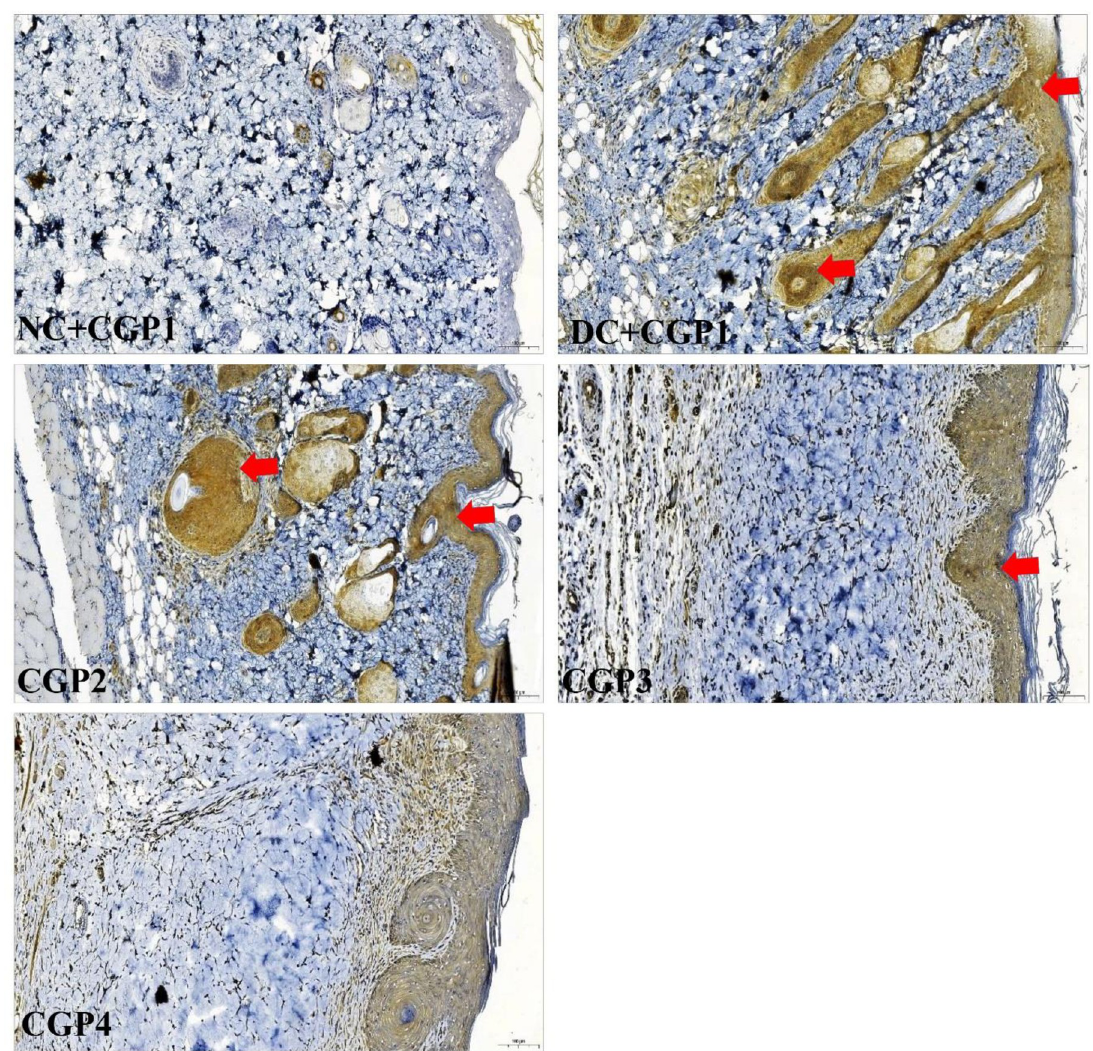
Fig 5. Effect of GC-AgNP CGPs dressing on Gsk-3 β in diabetic rats. Immunohistochemistry staining of Gsk-3 β (brown color). Red arrows point towards the distribution of Gsk-3 β protein in brown color. NC+CGP1: Normal control dressed with blank cotton gauze; DC +CGP1: Diabetic control rats dressed with blank cotton gauze; CGP2: Diabetic rats dressed with 13.06 μ M gallocatechin and silver nanoparticle (GC-AgNP) impregnated cotton gauze patches (DC+ 13.06 μ M CGP2); CGP3: Diabetic rats dressed with 26.12 μ M gallocatechin and silver nanoparticle (GC-AgNP) impregnated cotton gauze patches (DC+ 26.12 μ M CGP3). CGP4: Diabetic rats dressed with silver sulfadiazine (DC+AgS) impregnated cotton gauze patches. Data were expressed as mean ± S.E.M (n = 6). � p < 0.05 compared to control, # p < 0.05 compared to DC. Scale bar = 100 μ